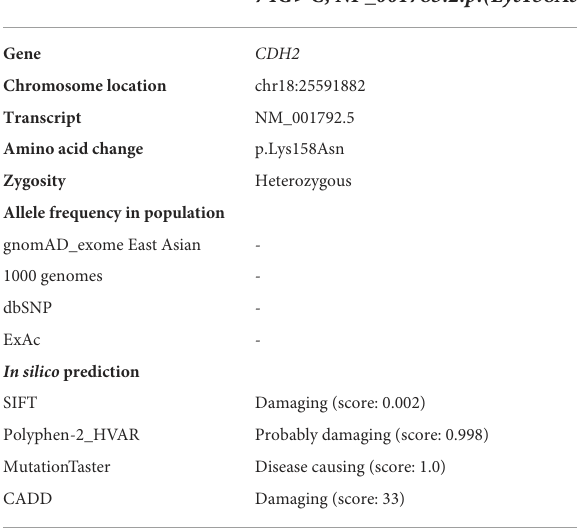
TABLE 2 Population Allele frequency and predicted pathogenicity score of the CDH2